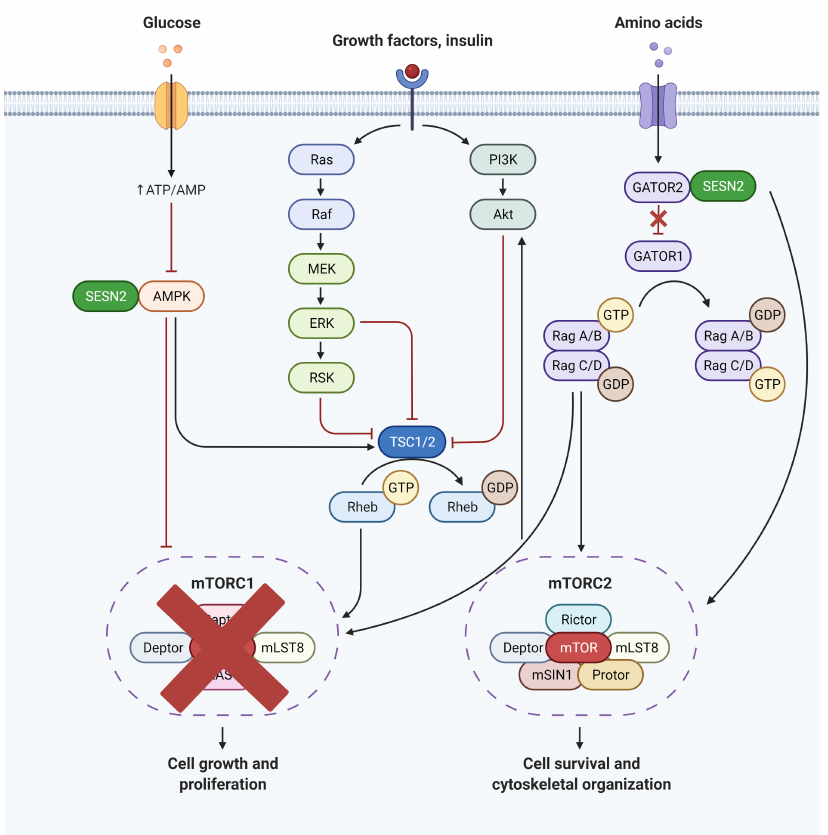
Figure 7. The Regulation of mTORC1, mTORC2, and AMPK by SESN2. The inhibition of mTORC1 by SESN2 is mediated either by AMPK or GATOR2. AMPK is activated by SESN2 which in turn directly inhibits mTORC1 or activates TSC2, a GAP for the mTORC1 regulatory protein Rheb. SESN2 is also known to inhibit GATOR2 in the absence of leucine so that GATOR1 can activate the GTPase activity of RAAG and inhibit mTORC1. SESN2-GATOR2 complex also interacts with RICTOR to increase the catalytic activity of mTORC2 and activate AKT signaling. Akt: Ak strain transforming; AMPK: AMP-activated Protein Kinase; ERK: Extracellular signal-Regulated Kinase; GATOR1: